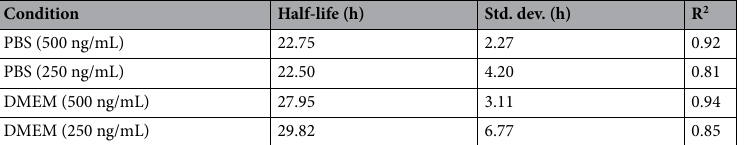
Condition Half-life (h) Std. dev. (h) R